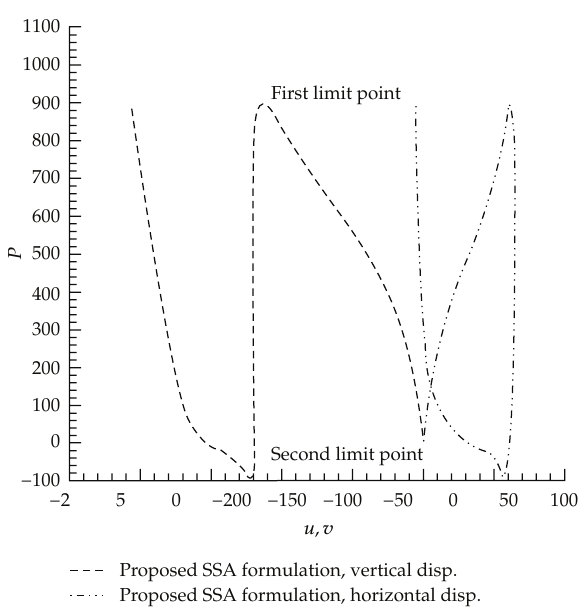
Figure 5: Postbuckling behavior of the circular arc, using higher order approximation